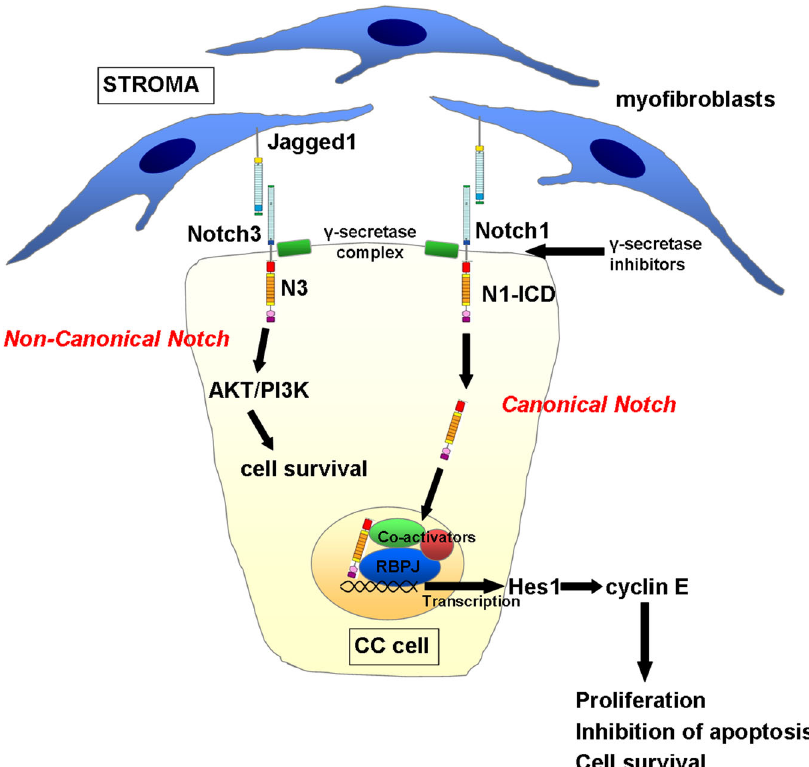
Fig. 3 Notch is over-activated in CC and drives tumour cell survival. Schematic micrograph of the provision of Notch ligand (Jagged1) by myo fi broblasts in the CC stroma; triggering Notch activity in adjacent CC cells. Notch1 and the atypical Notch3 receptor are over-expressed in human and rodent models of CC, and both appear to drive CC proliferation. Notch1 acts via the canonical pathway, releasing Notch1 intracellular domain (N1-ICD), which translocates to the nucleus, drives transcription of classical Notch effectors including Hes1, which then promotes proliferation through expression of genes including Cyclin E. Notch3 appears to stimulate activity through the AKT/PI3K cell survival pathway independent of the effector of canonical Notch, RBPJ κ . A further level at which the pathway can be therapeutically targeted is the point of receptor cleavage in the membrane. Inhibitors of the enzyme complex gamma-secretase have demonstrated anti-tumoural activity in cell culture systems, xenografts and toxin driven models in